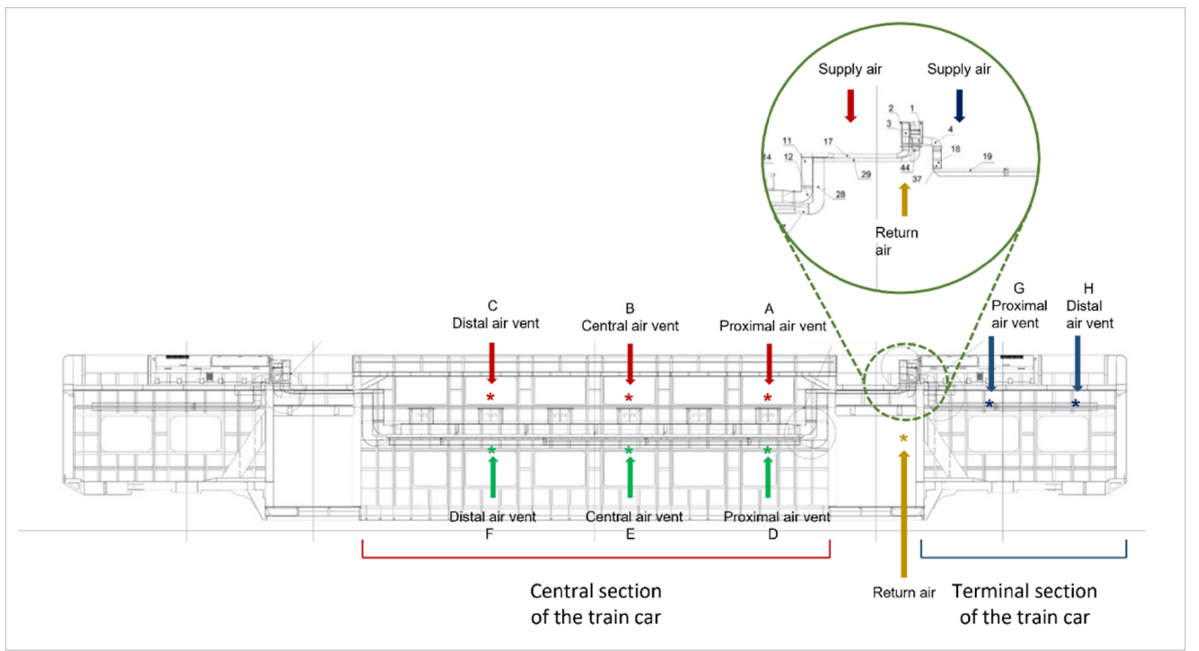
Figure 4. Experimental setting in the Vivalto train. Sampling sites: proximal (A), central (B) and distal (C) air vent panels of the upper central section of the train car (red arrows); the proximal (D), central (E) and distal (F) air vent panels of the lower central section of the train car (green arrows); the proximal (G) and distal (H) air vent panels in the terminal section of the train car (blue arrows). Point of determination of E. coli starting concentration after nebulization (yellow).